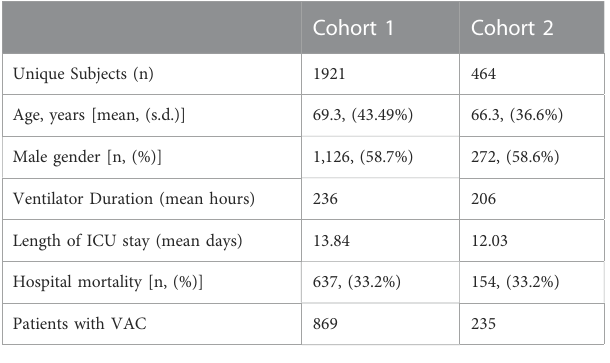
TABLE 3 VAC Cohort patients.